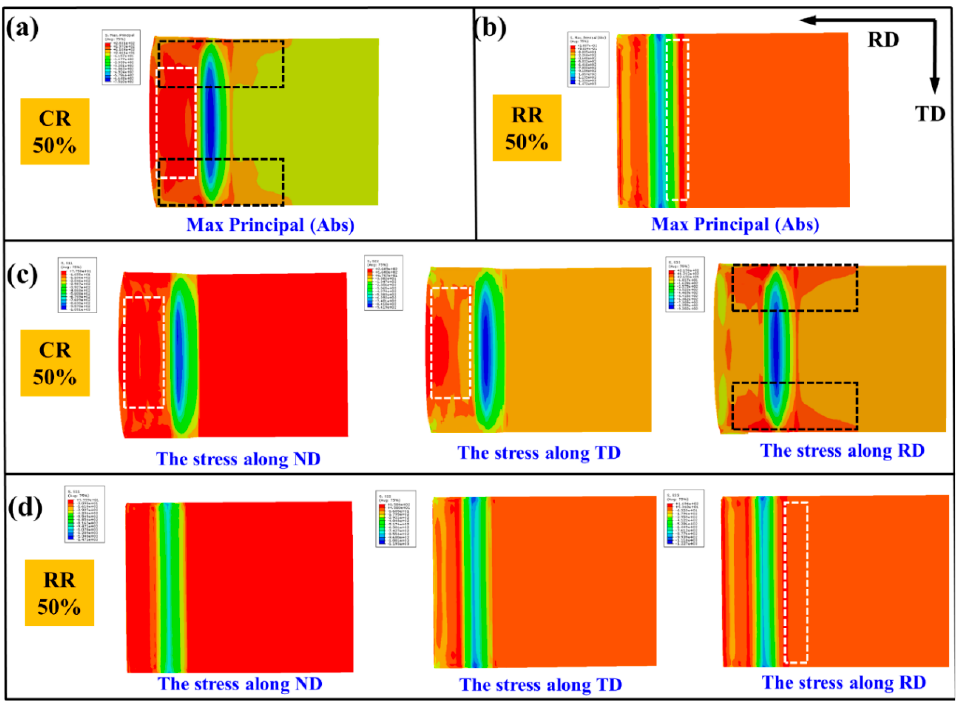
Figure 13. Abaqus analysis of the stress distribution of the ( a , c ) CR50% and ( b , d ) RR50% plates.